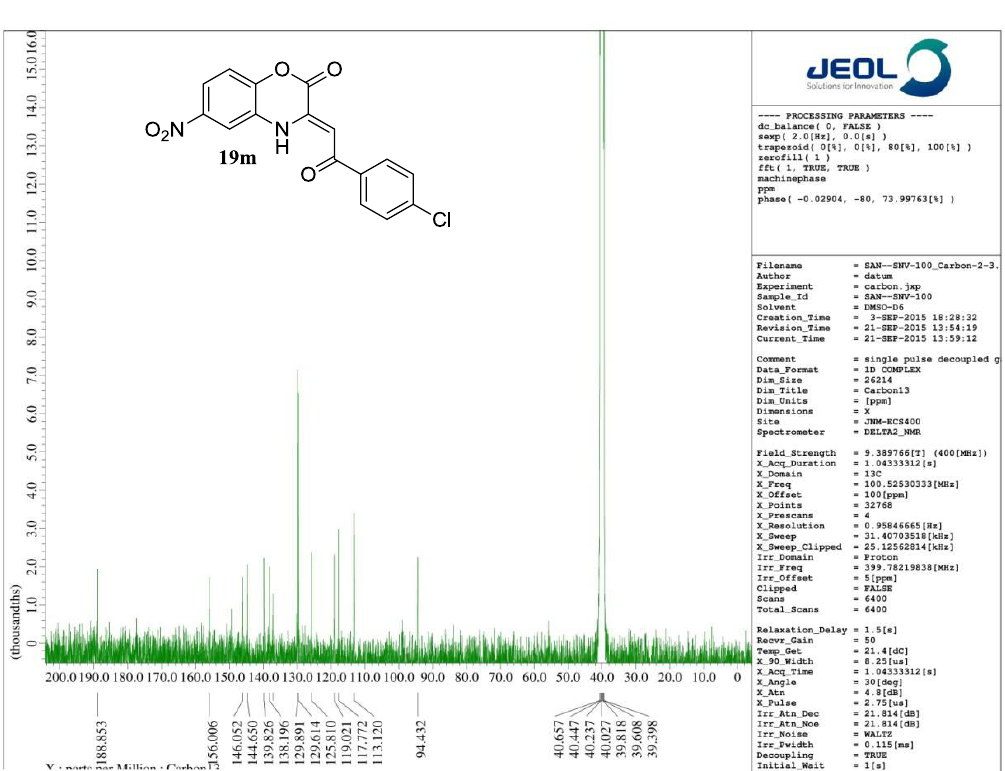
Figure 25. 1 H NMR Spectra of Compound 11m .